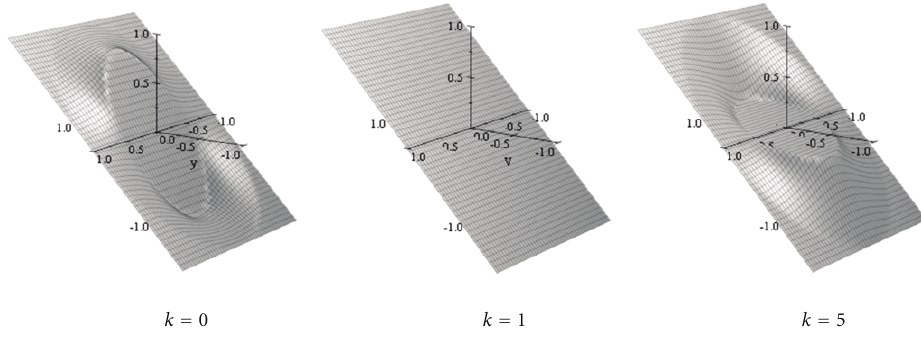
k = 0 k = 1 k = 5 Figure 3: The solution of (cid:3) 3.26 (cid:4) for the cases when the conductivity of the disk B is k (cid:2) 0 , k (cid:2) 1, and k (cid:2) 5,